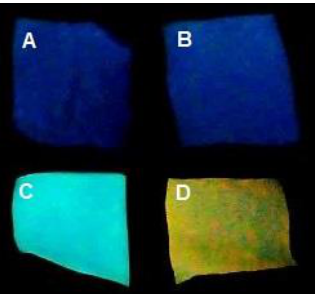
Figure 4. Real image of fabric samples under UV lamp ( λ em = 365 nm): uncoated ( A ), silica coated ( B ), blue Ir@SiO 2 - coated ( C ) and red Ir@SiO 2 - coated ( D ) cotton textiles.